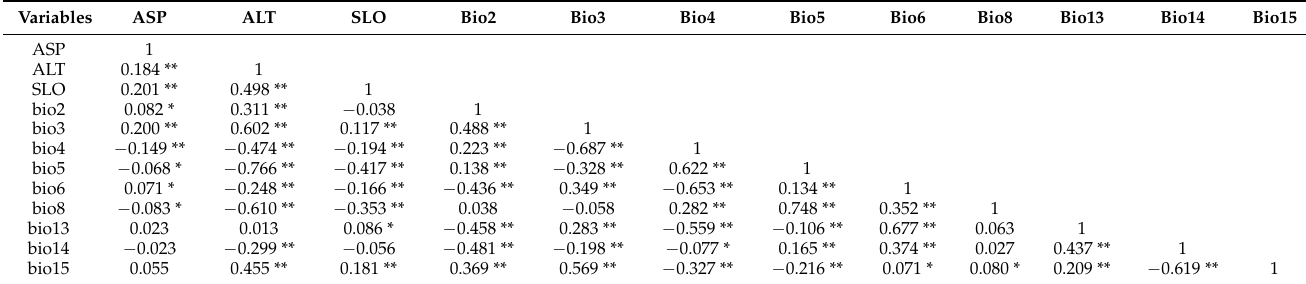
Table A2. Multicollinearity test using Pearson correlation coefficients of twelve important environmental variables. (** and * indicate a significance level of 0.01 and 0.05,